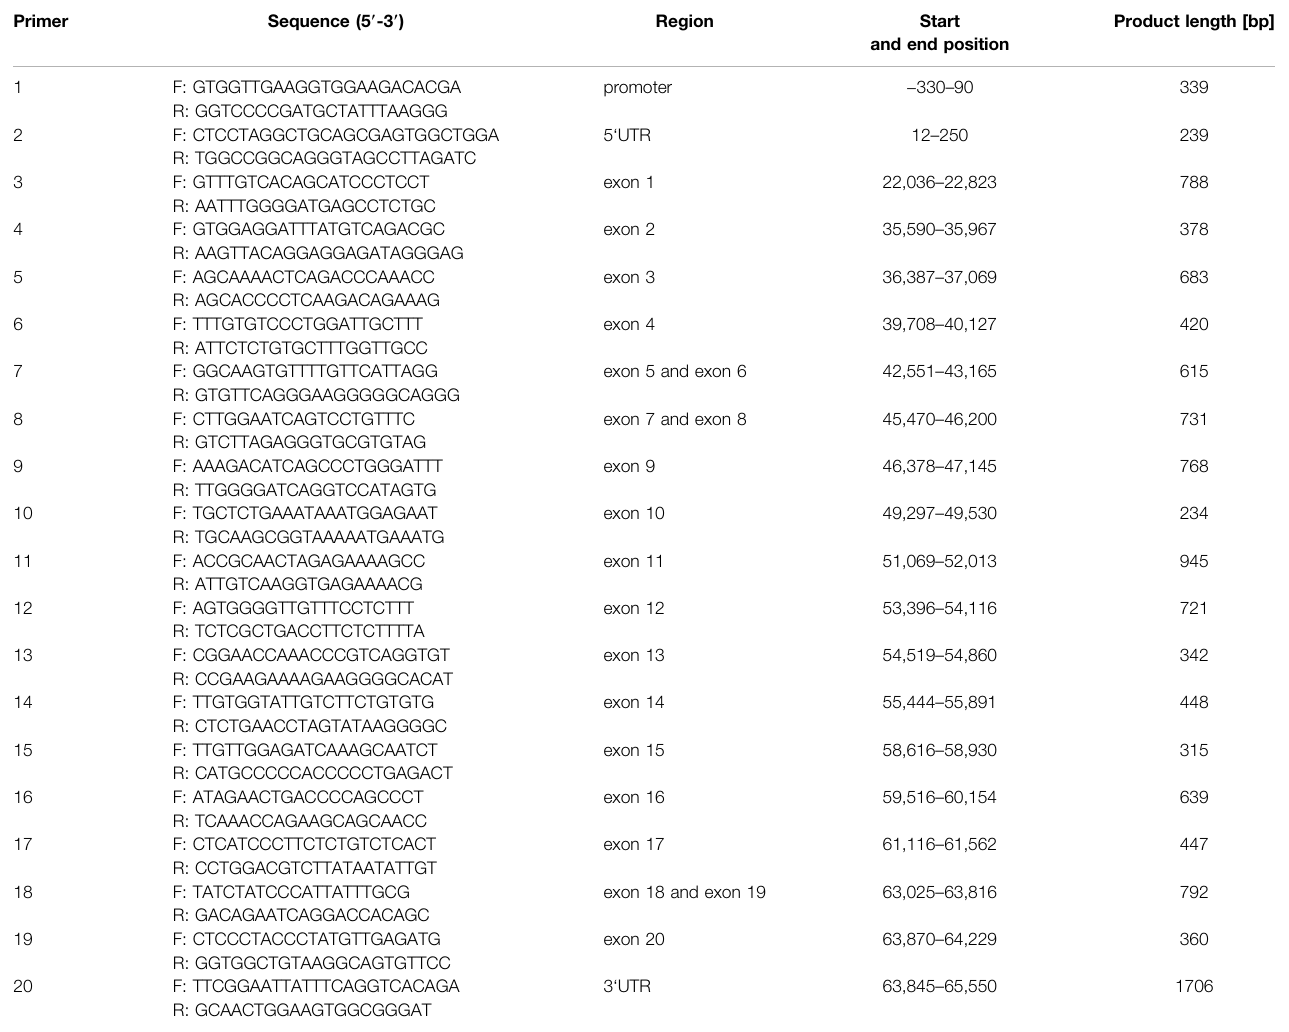
TABLE 1 | Primer information for the buffalo ACSL1